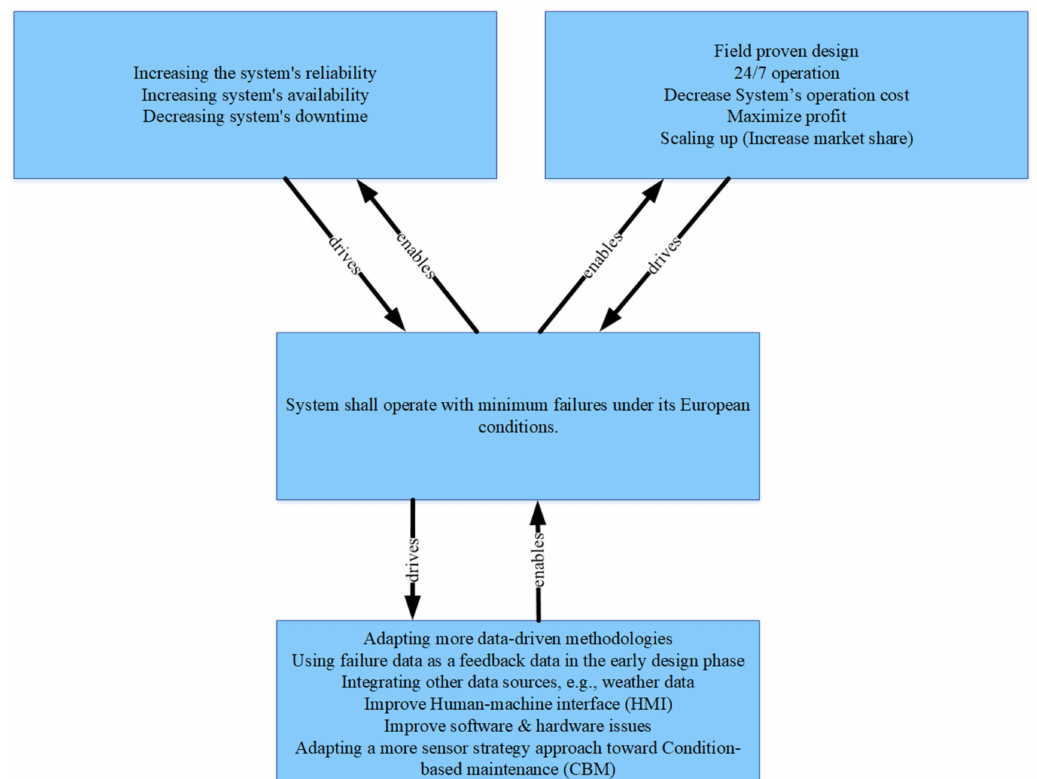
Figure 28. Elevator pitch: conclusion and recommendation